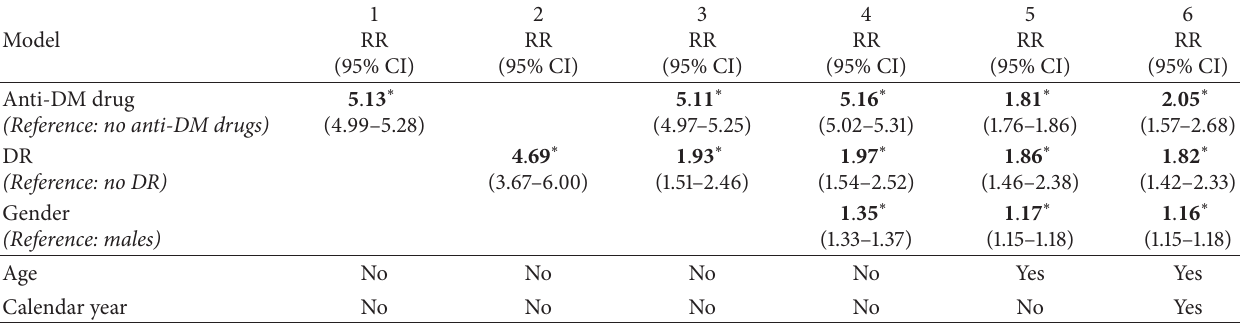
Table 1: Duration analysis. The table shows the relative risk for developing glaucoma in patients treated with antidiabetic drugs in the Danish population (1996–2012). The model controls for complication with DR and age as well as calendar year fixed effects (omitted from the table). RR: relative risk; CI: confidence interval; anti-DM drug: antidiabetic